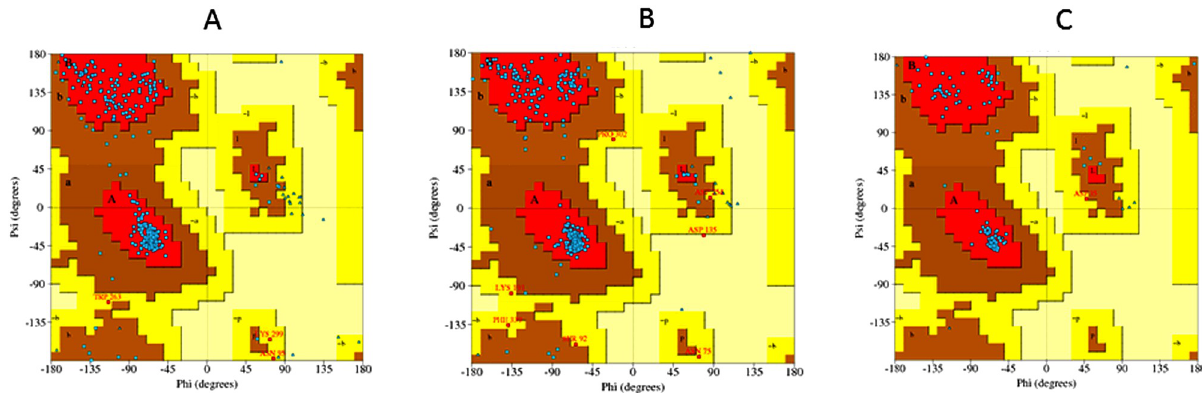
Fig 8. Ramachandran plot analysis of traget proteins nrtACD. Red regions in the graph indicate the most allowed regions and yellow the allowed region. (A) nrtA, (B) nrtC and (C) nrtD.